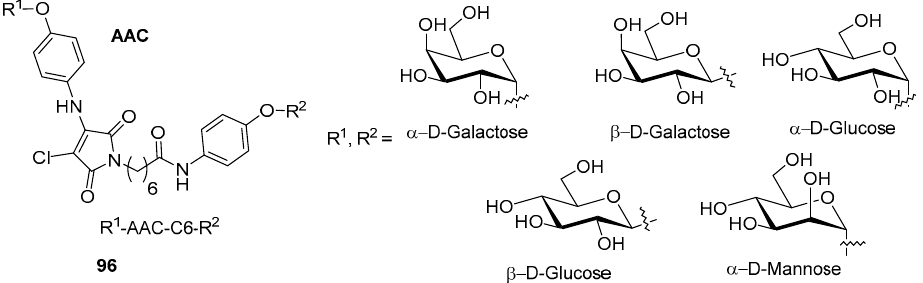
Figure 56. Structures of N-alkyl-2-anilino-3-chloromaleimide (AAC) containing bola-amphiphilic glycolipids with periph- eral sugar units [111].